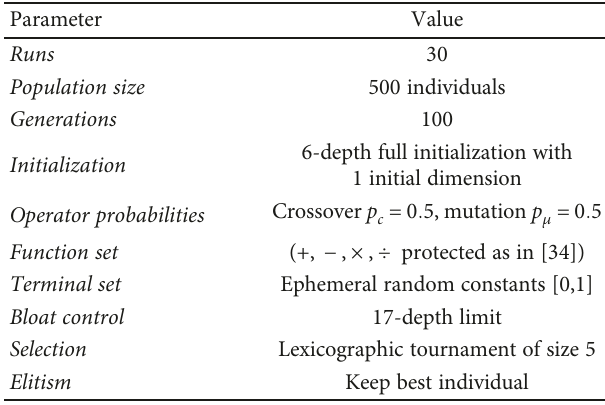
Table 2: Parameters used by M3GP to obtain the results reported in Figure